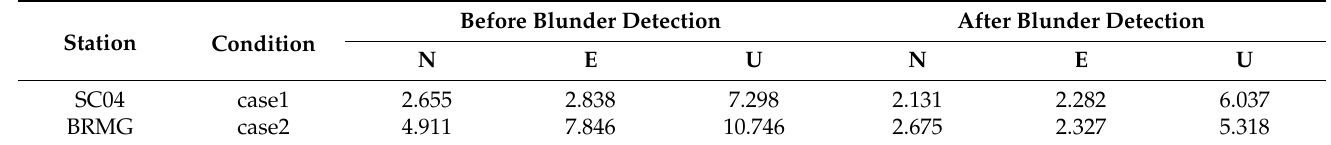
Table 8. Std value in NEU direction of SC04 and BRMG stations (m).